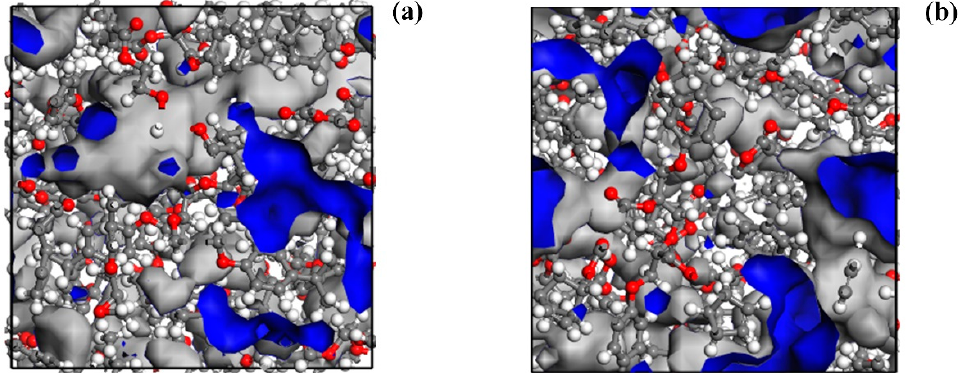
Figure 8. Free volume of ( a ) DGEBA-MTHPA; ( b ) DGEBA-NA.